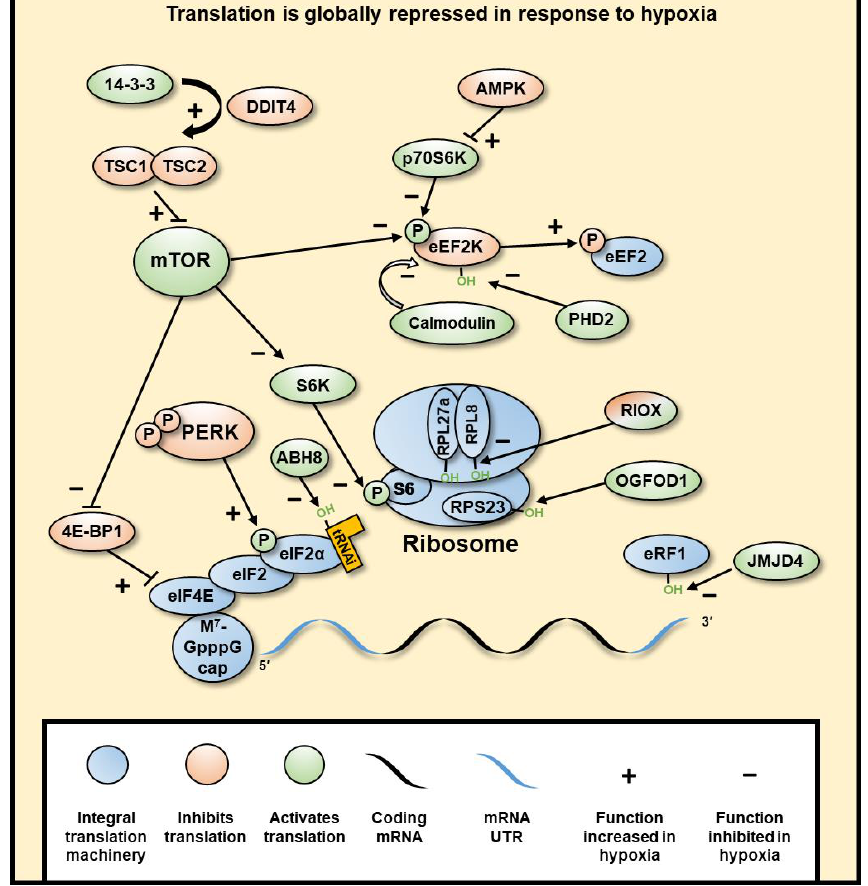
Figure 4. Hypoxia induces a global inhibition of protein translation. Global translation is mostly inhibited at initiation through mTOR inhibition of eIF4 and PERK inhibition of eIF2α, subsequently decreasing cap-dependent translation of mRNA. mTOR is inhibited through hypoxia-induced DDIT4-dependent release of TSC2 from 14-3-3 binding proteins, resulting in the inhibition of mTOR by TSC1/2 dimer. Elongation is also regulated through mTOR, as well as AMPK through its inhibition of RPS6KB1, wherein hypoxia eEF2K is not inhibited, which allows its phosphorylation and inhibition of eEF2. PHD2 can also hydroxylate eEF2K, which in normoxia causes its disassociation from calmodulin, decreasing its autophosphorylation. Termination is regulated by JMJD4-mediated hydroxylation of eRF1, which is required for termination. Selective translation of genes in hypoxia is regulated by UTR sequences, such as IRES and uORFs, which allow increased translation specifically in hypoxia. RNA binding proteins can bind to various parts of the mRNA and result in different regulatory outcomes. The ribosome can also be hydroxylated by RIOX1 and RIOX2, though it is not yet clear what role these modifications have.